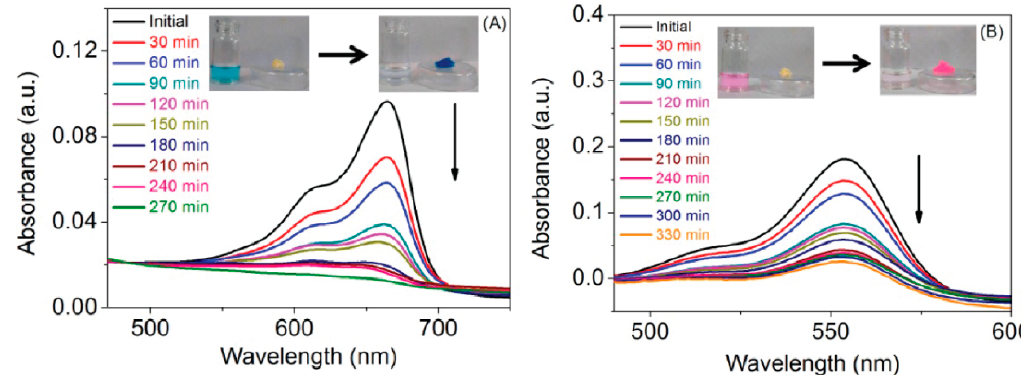
Figure 6. UV–Vis spectra of methylene blue (MB) ( A ) and rhodamine-B (RhB) ( B ) adsorption by DC200 gels at different time intervals.